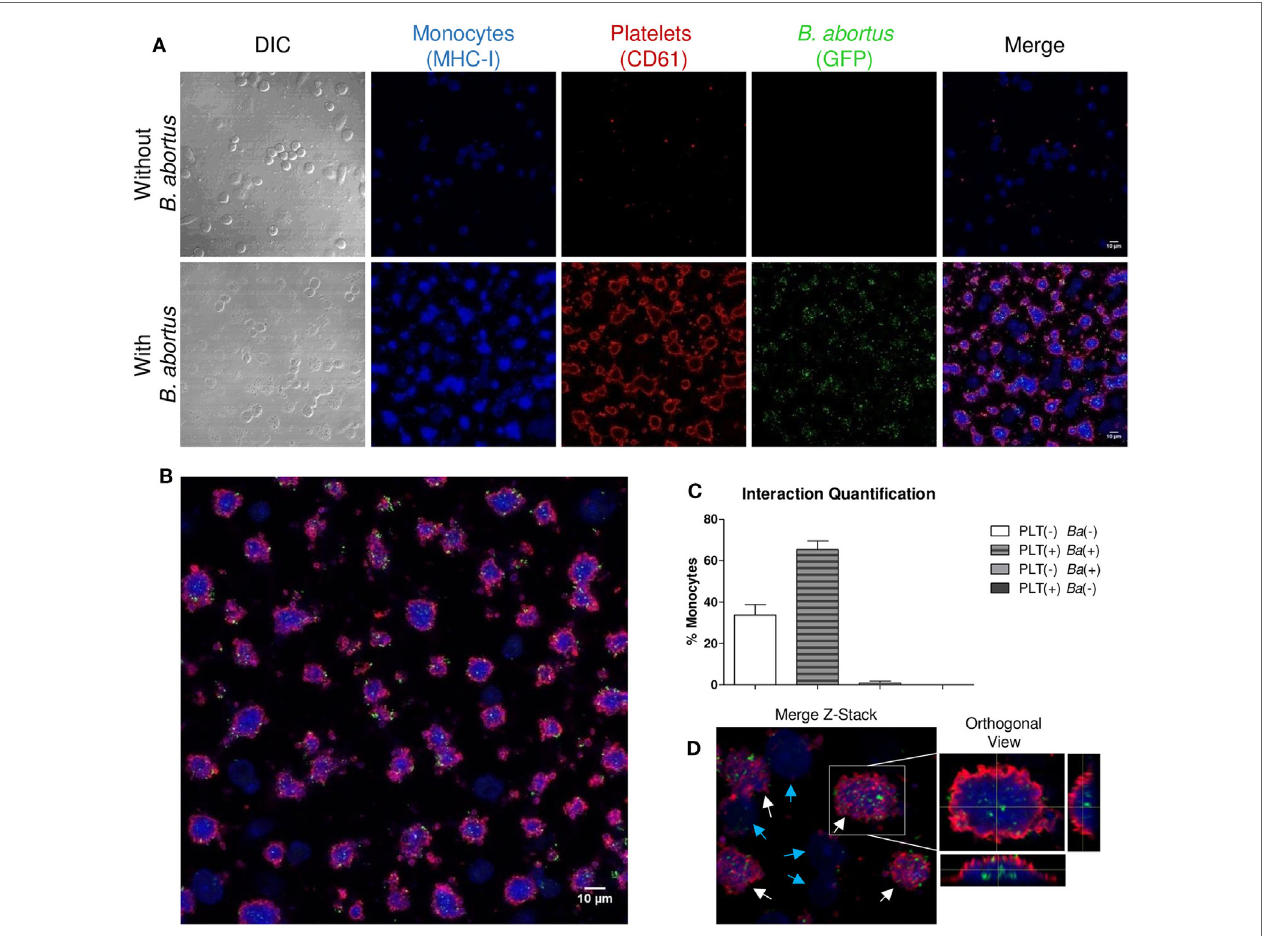
FigUre 3 | Platelets surround Brucella abortus -infected monocytes. (a) Confocal micrographs of THP-1 cells infected with green fluorescence protein (GFP)- B. abortus in presence or absence of platelets for 4 h. Monocyte population was stained with an anti-human MHC-I primary Ab and Alexa-633-labeled secondary Ab (blue). Platelet population was stained with an anti-human CD61 primary Ab and Alexa-546-labeled secondary Ab (red). (B) Confocal panoramic micrograph of THP-1 cells infected with GFP- B. abortus in presence of platelets, representative of the micrographs used for the interaction quantification. (c) Quantification of the interactions between populations. The monocytes subpopulations were defined as: non-infected and without platelets (double-negatives), infected and associated with platelets (double-positives), only infected (GFP-positives), and only associated with platelets (CD61-positives). Data are expressed as percentage of monocytes ± SEM of three independent experiments. The number of cells counted per experimental group was 200. (D) Merge Z-stack and orthogonal view of THP-1 cells infected with GFP- B. abortus in presence of platelets for 4 h. Blue arrows indicate non-infected THP-1 cells while white arrows indicate infected THP-1 cells surrounded by